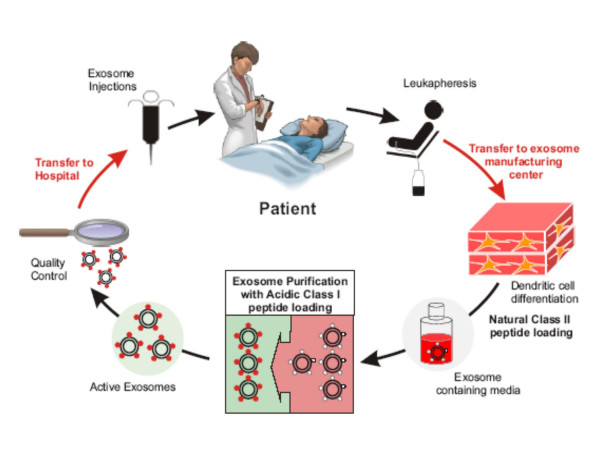
Study design. Different weeks (W) of the study are described. Screening, HLA typing and tumor evaluation were performed within 2 weeks before lymphapheresis. DTH (Multi Mérieux skin test) was performed at the time of lymphapheresis, and exosome vaccine started 3 weeks later.